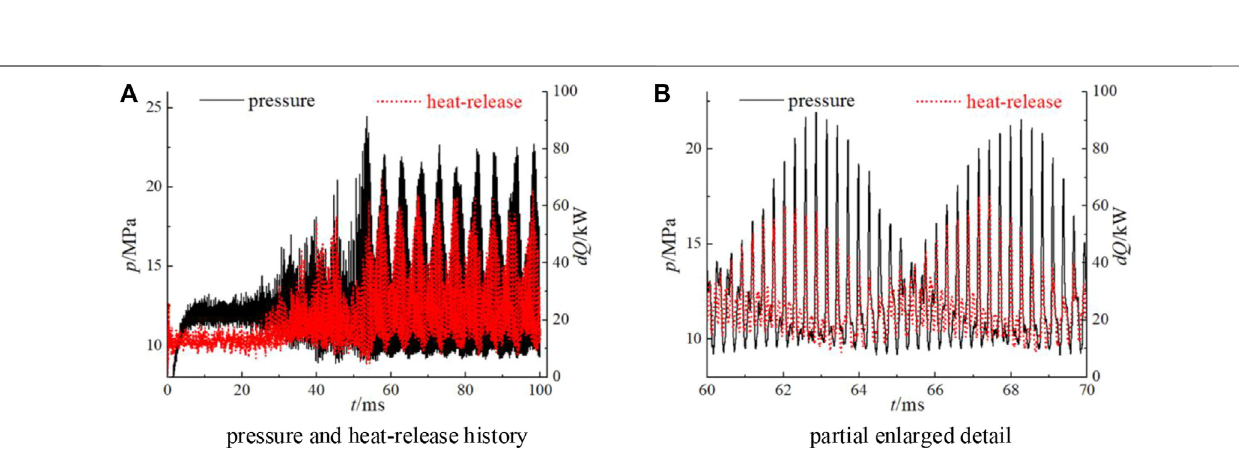
FIGURE 9 | Relationship between pressure and heat-release in case2 (probe is near the wall and 50 mm downstream from injector faceplate). (A) pressure and heat-release history. (B) partial enlarged detail of (A) .